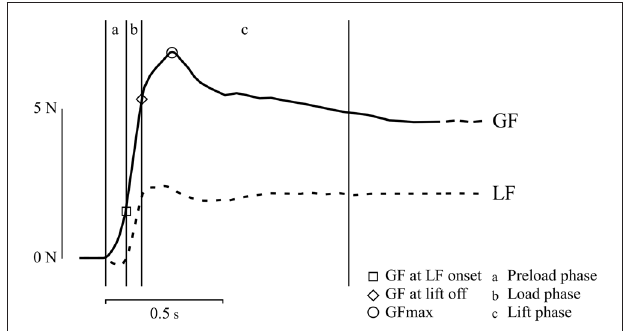
FIGURE 2 | Time course of GF (continuous trace) and LF (dotted trace) during a typical trial of the grip-lift-hold task. The Preload phase (a) corresponds to the time separating the first contact of one finger on the apparatus and the onset of a positive LF. The Load phase (b) corresponds to the time during which a parallel increase of GF and LF is observed. The Lift phase (c) corresponds to the time during which the apparatus is raised and stabilized over the table. Several force measures were extracted from the waveforms. The GF at LF onset corresponds to the value of GF at the beginning of the Load phase. The GF at lift-off corresponds to the value of GF when LF equals the weight of the apparatus, i.e., when the apparatus begin its lift-off. The GF max corresponds to the maximum value of GF. Values are in Newton (N) and second